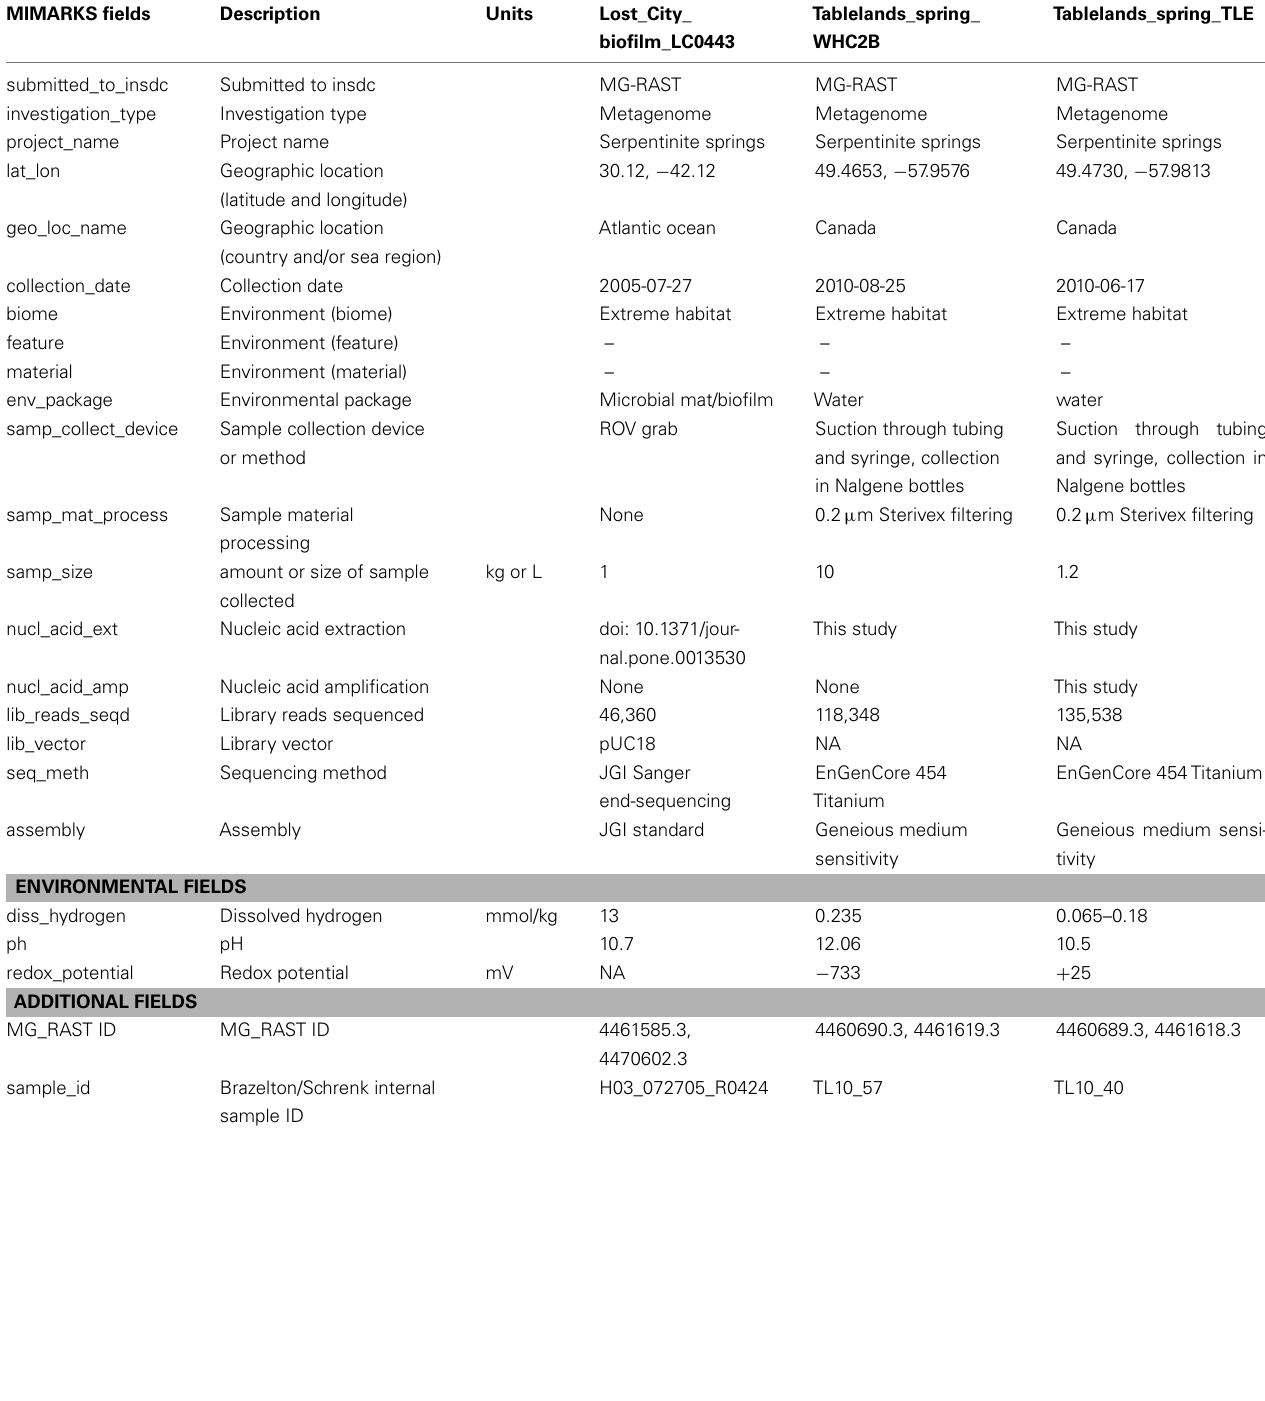
TableA1 | MIMS-compliant metadata for lost city and tablelands